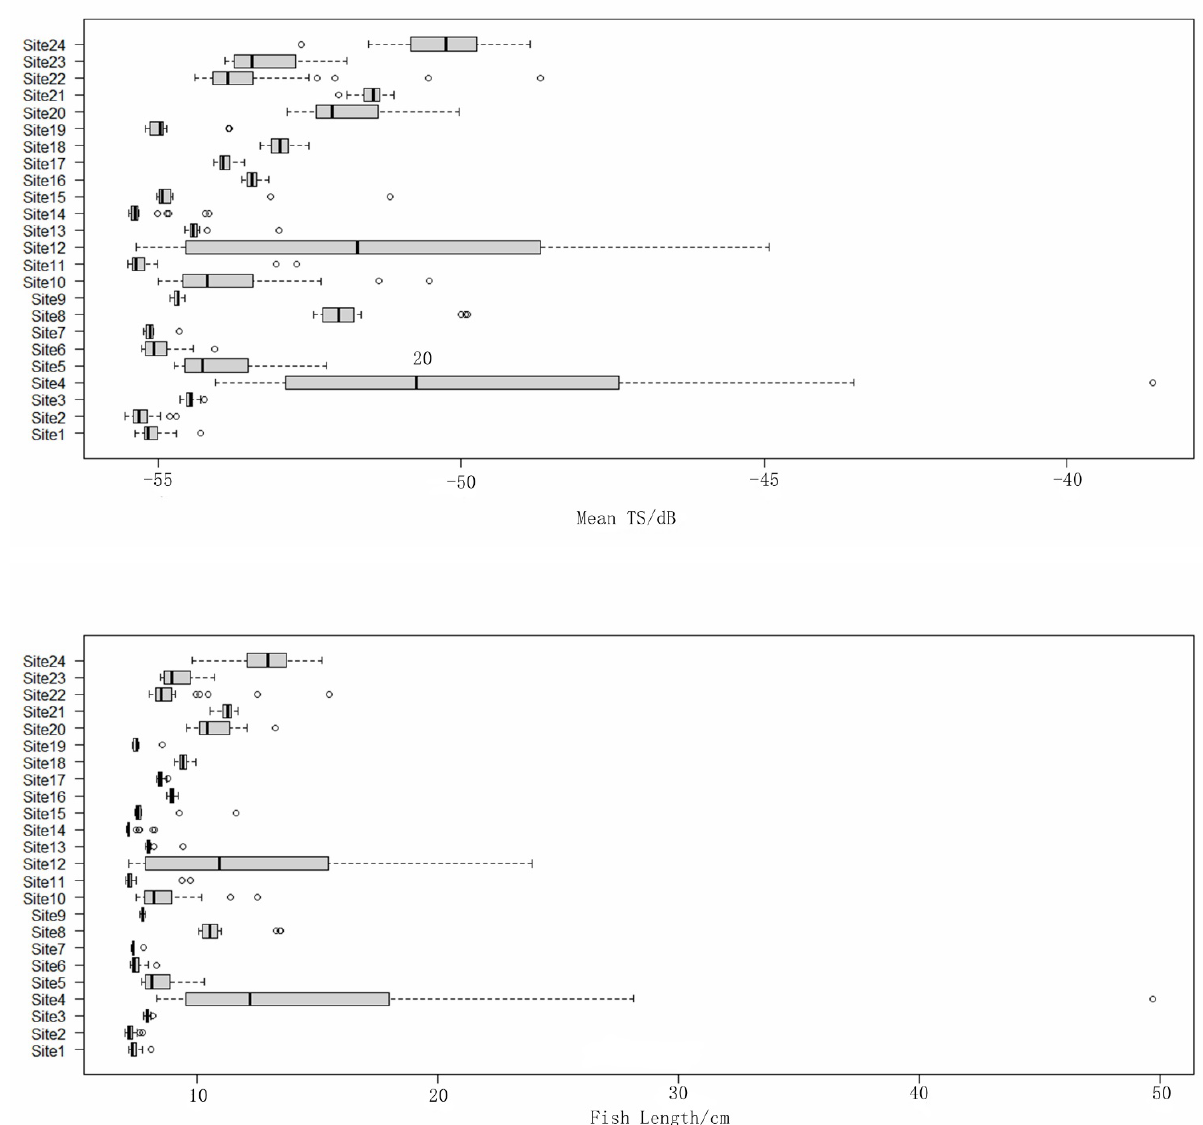
Figure 2. Frequency profile of target strength in study area.